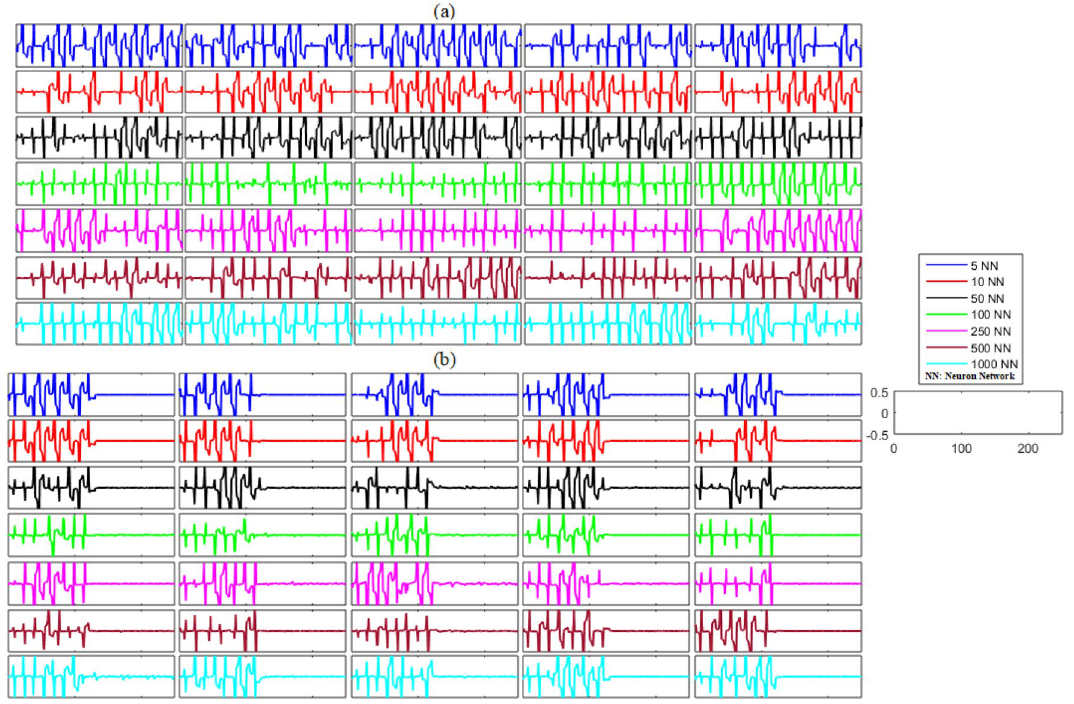
Figure 6. ( a ) Without control synchronization dynamics of the membrane potential states (x-states) of different time-delayed bidirectional FHN networks without noise. ( b ) Controlled synchronized error dynamics of the membrane potential states (x-state) of different time-delayed bidirectional FHN networks without noise.